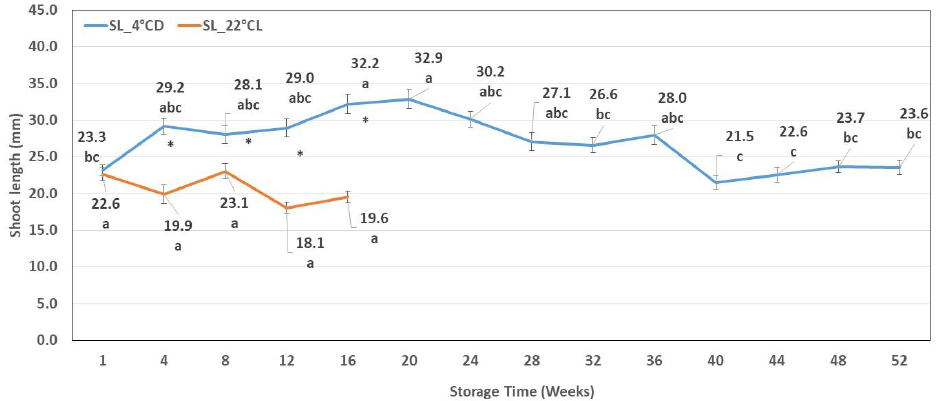
Figure 7. Shoot length (SL) of new shoots developed on subcultured explants from cold storage (SL_4 ◦ CD) and from the growth chamber (SL_22 ◦ CL). Line graphs present mean values ± SE of the SL of new shoots developed from subculture. Lower case indicates the significant differences between the SL measured after different storage times. * indicates the significant differences between the SL measured after different storage conditions.